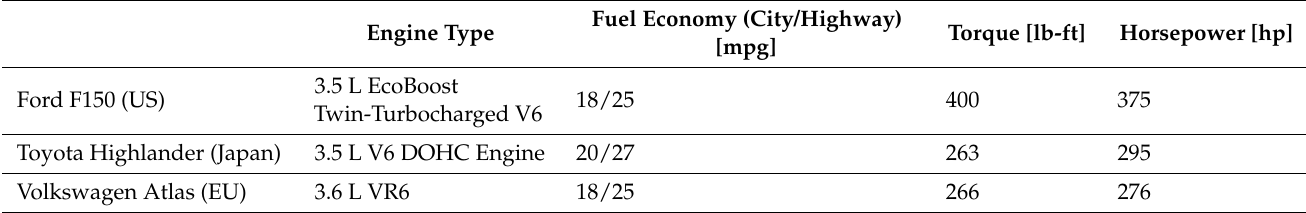
Table 2. The main characteristics of various V engines.